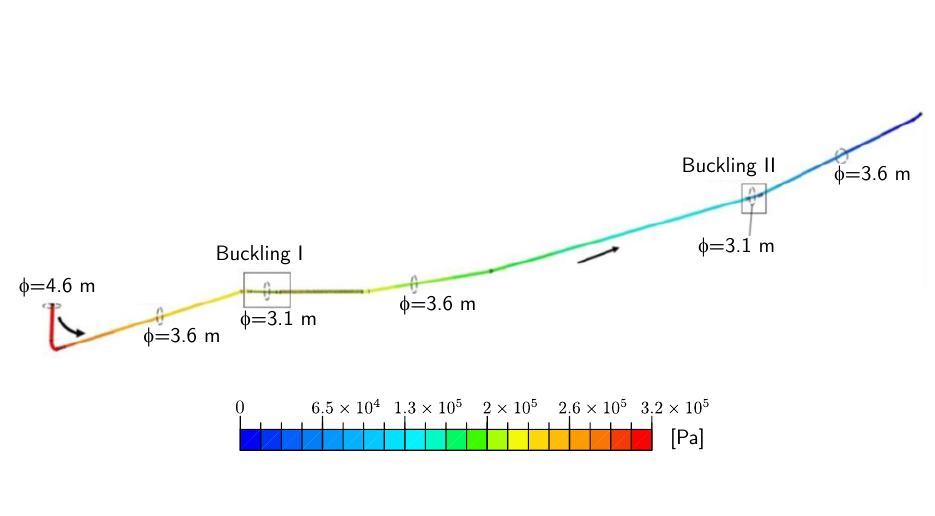
Figure 11. Pressure head loss along Chivor II headrace